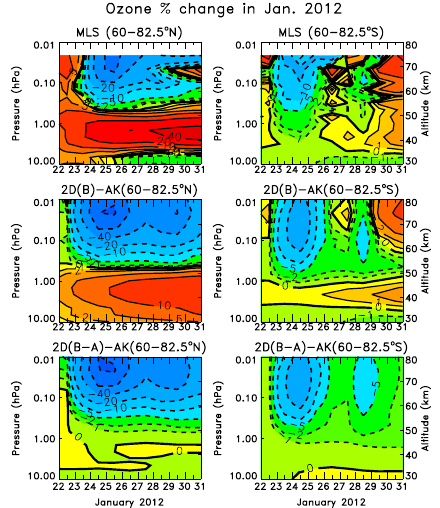
Fig. 5. Daily averaged ozone changes from Aura MLS measure- ments ( Top ) and GSFC 2-D model predictions ( Middle, Bottom ) for the 60–82.5 ◦ N band ( left plots ) and the 60–82.5 ◦ S band ( right plots ). An average observed (predicted) ozone profile for the period 18–22 January 2012 was subtracted from the observed (predicted) ozone values for the plotted days of 22–30 January 2012 for Aura MLS measurements ( Top ) and for the GSFC 2-D model simulation “B (with SPEs)” ( Middle ). The Bottom plot shows the difference be- tween GSFC 2-D model simulations “B (with SPEs)” and “A (with- out SPEs).” The contour intervals for the ozone differences are − 80, − 60, − 40, − 20, − 10, − 5, − 2, − 1, 0, 1, 2, 5, 10, 20, and 40%. The MLS averaging kernel (AK) was used to sample the model